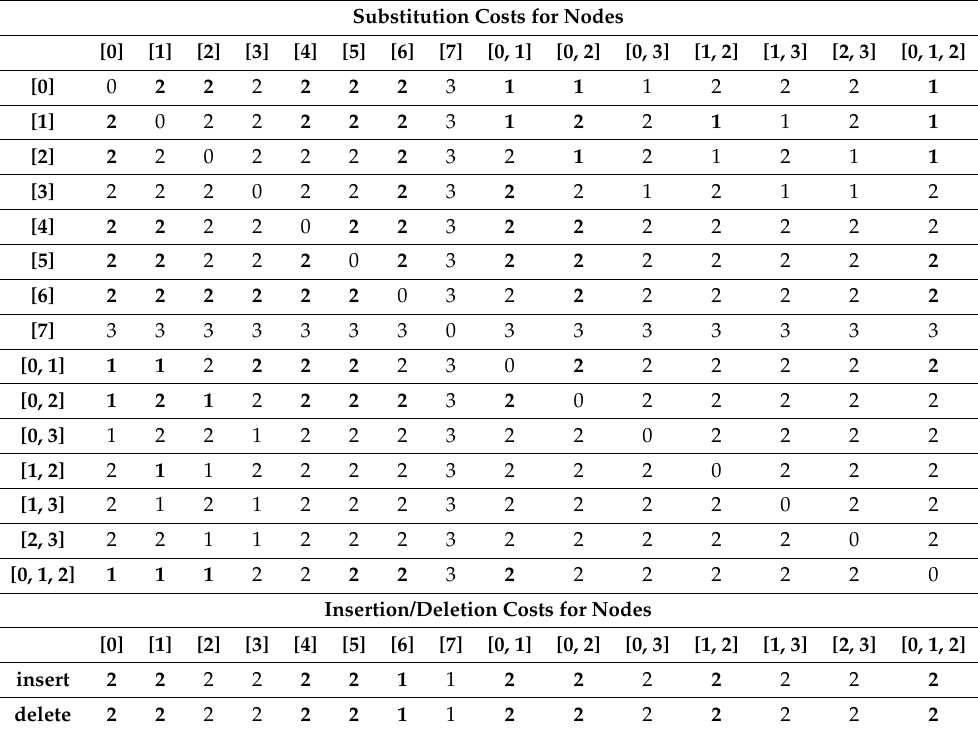
Table 3. Substitution, insertion and deletion costs for nodes proposed by Harper et al. [33]. Substitution Costs for Nodes